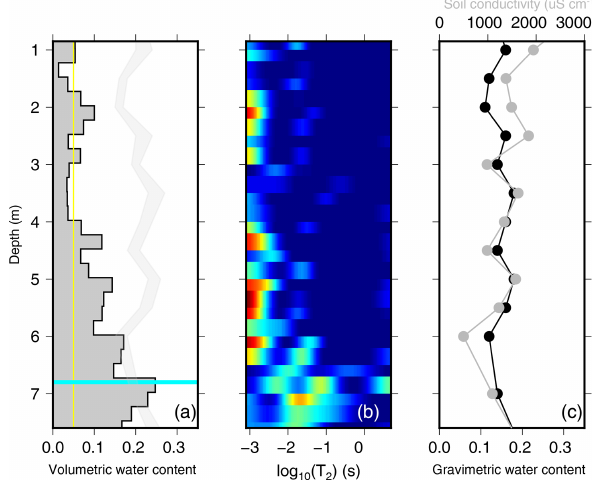
Figure 4. Results from the downhole NMR sounding and soil sam- ples at the drill hole location versus depth (metres below ground level; Fig. 1). (a) The water content profile from the downhole NMR data. The thin vertical yellow line shows the average noise level (0.05m 3 m − 3 ) below which water content estimates are question- able. The thick horizontal cyan line represents the manually mea- sured water level from ground surface (6.8m). The thin transparent region is the volumetric water content estimated from the measured gravimetric water content, assuming a soil density between 1.3 and 1.5gcm 3 . (b) The T 2 distributions that produced the water content curves in (a) . The maximum water contents are calculated by sum- ming the area under the distribution. (c) Soil conductivity (grey) and gravimetric water contents (black) as a function of